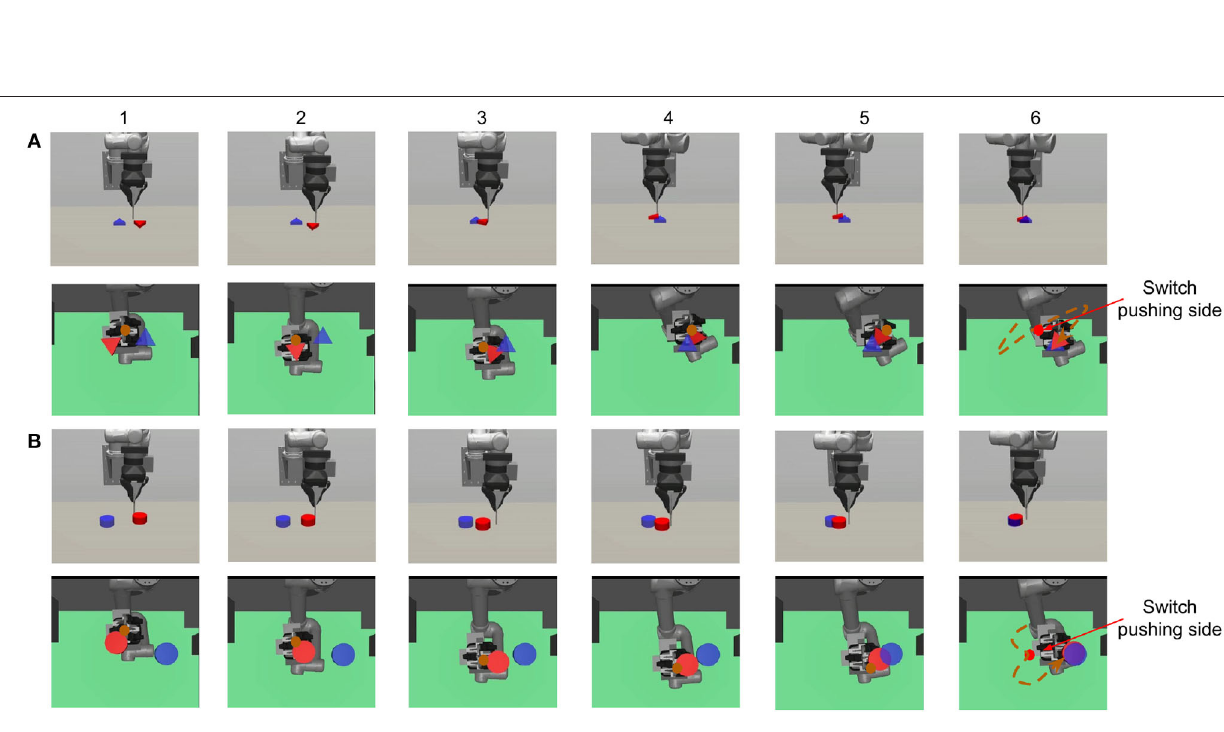
FIGURE 2 | The figure shows two pushing processes: (A) triangle and (B) cylinder. Both the initial and target position are generated randomly at the beginning of each episode. We show both the front view (first row) to give an overall robot-object scene and the bottom view (second row) to show what the robot sees. The transparency of the table is set to 0.3 in the simulation. The brown point in (1–5) and the dashed line in (6) represent the pusher position and trajectory. In both (A,B) , we can see that the robot learns to first choose a proper initial pushing direction and to switch the pushing side when the object deviates from the target. The final orientation error in (B) is explained in Section